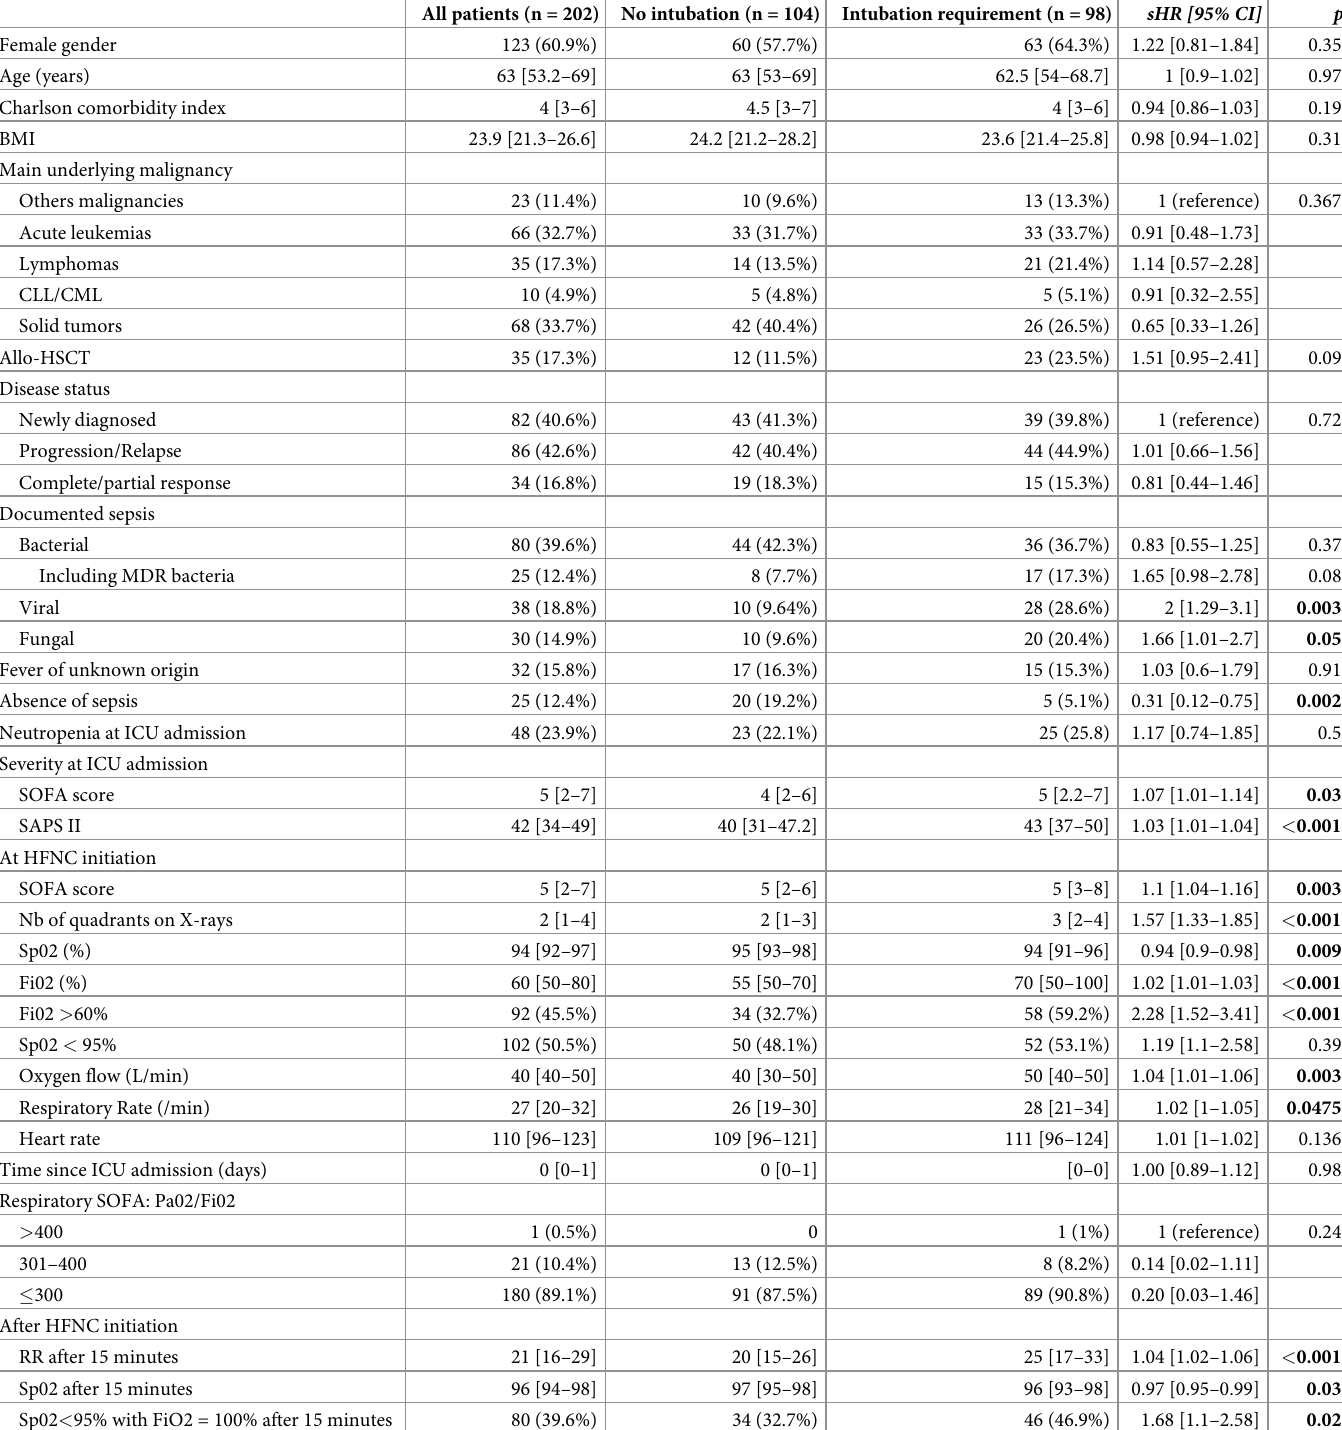
Table 3. Characteristics of patients treated with HFNC: Comparison of HFNC success with HFNC failure requiring